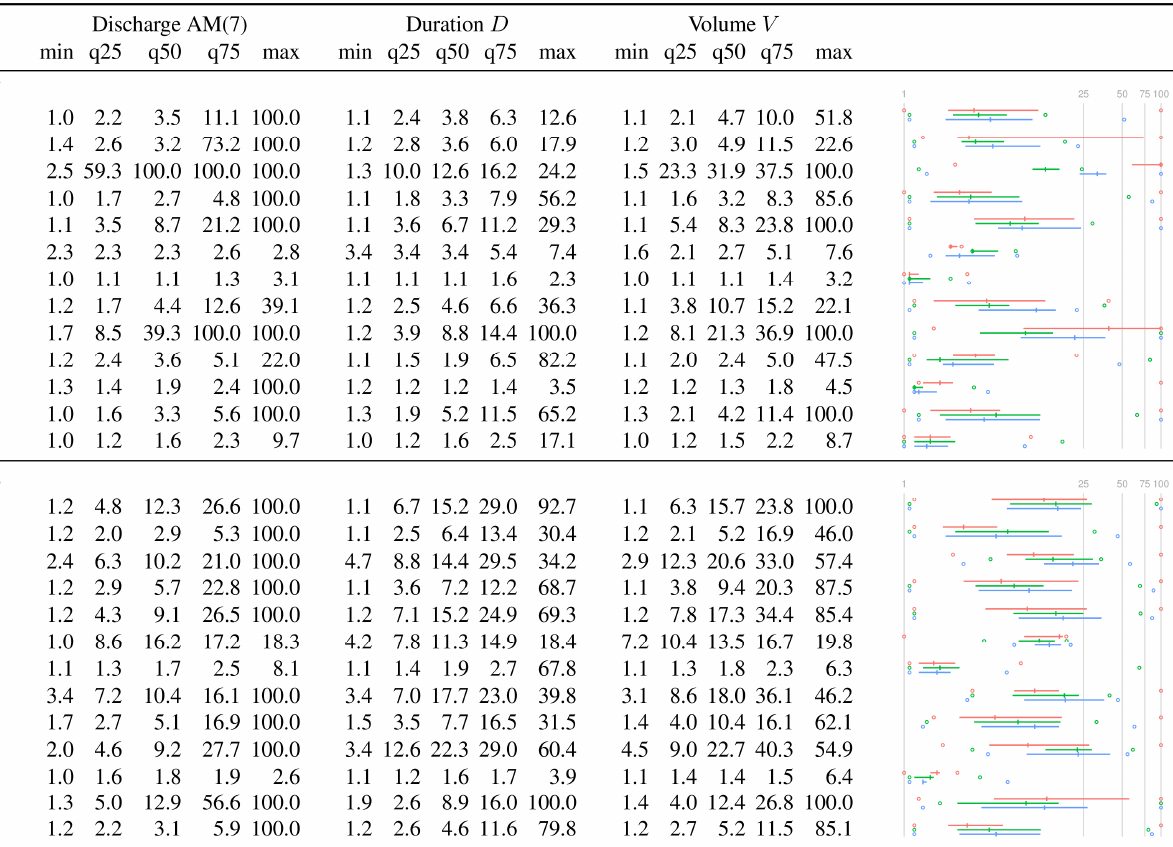
Table A2. Statistical summary of low flow and streamflow drought characteristics of stations with predominant summer seasonality: 2015 (top) and 2003 (bottom). Symbols and legend are those of Table